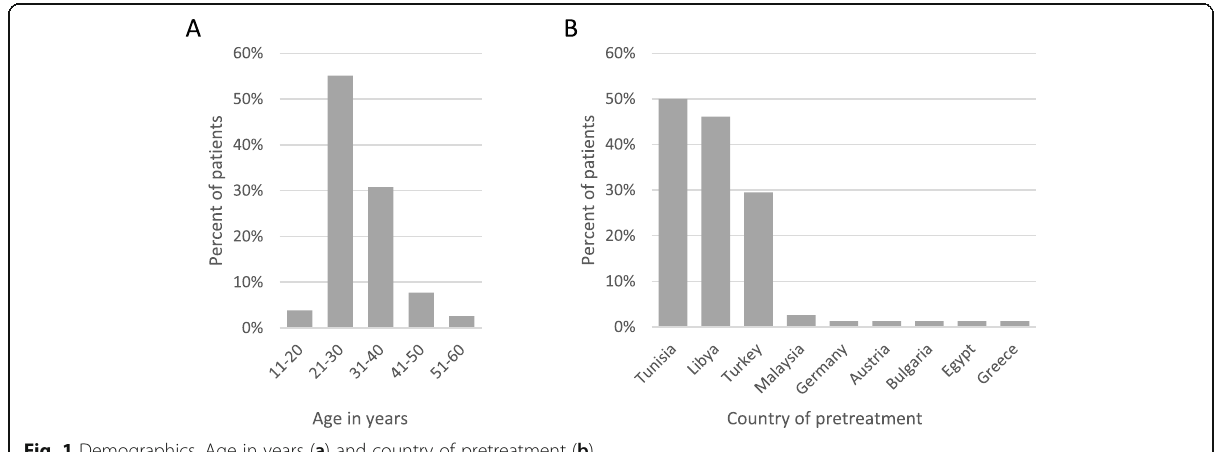
Fig. 1 Demographics. Age in years ( a ) and country of pretreatment ( b